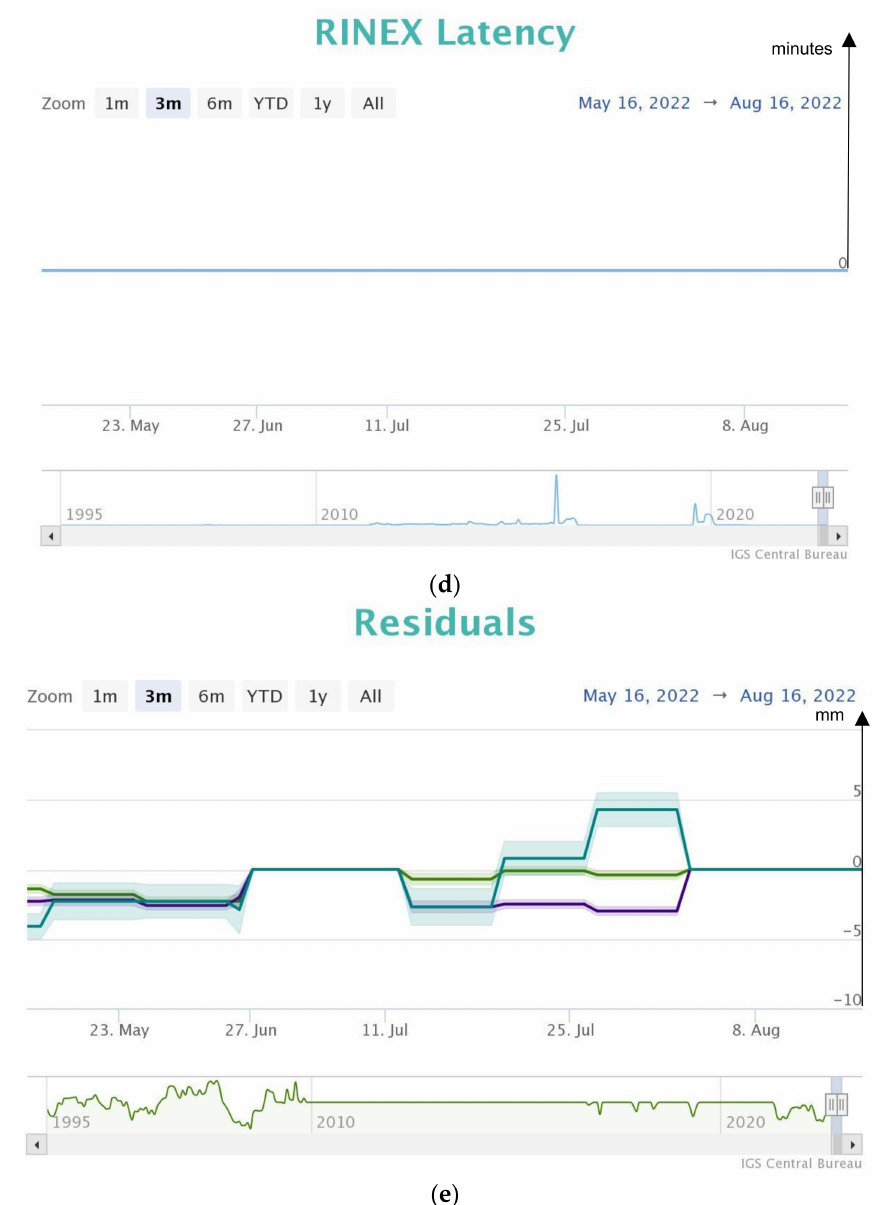
Figure 1. IGS daily data assessment results at LBCH station from 16 May to 16 August 2022. ( a ) Daily RINEX observations (no BDS and QZSS data); dotted line: expected, solid line: observed. ( b ) Cycle slips (GPS, BDS, and QZSS are always zero). ( c ) RMS multipath in meters (Galileo MP2, BDS, and QZSS are always zero). ( d ) RINEX latency in seconds (always zero). ( e ) Residuals in millimeters; green: north, purple: east, aqua: vertical. (Plots are downloaded from the IGS website; text/scale cannot be